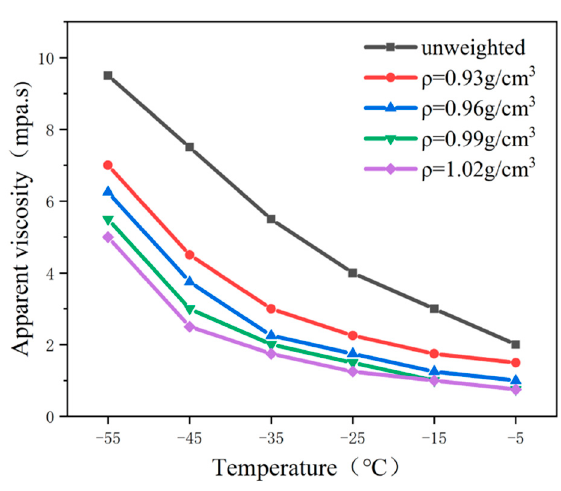
Figure 3. Influence of the weighting agent addition on the apparent viscosity of the drilling fluid.